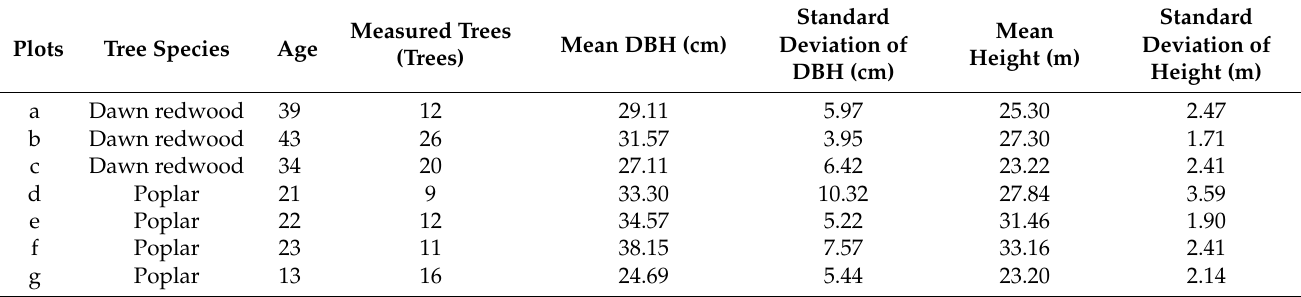
Figure 1. Study area and distribution of sample plots. The study area was located in Dongtai City in the east of Jiangsu province (see the subfigure in the top left) near the coast of the Yellow Sea. Table 1. Summary of the structural attributes of the field